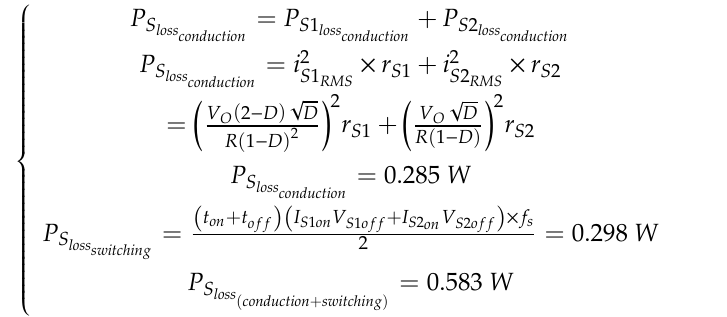
Figure 17. Output voltage and voltage stress across switch S 1 and S 2 at D = 0.4.